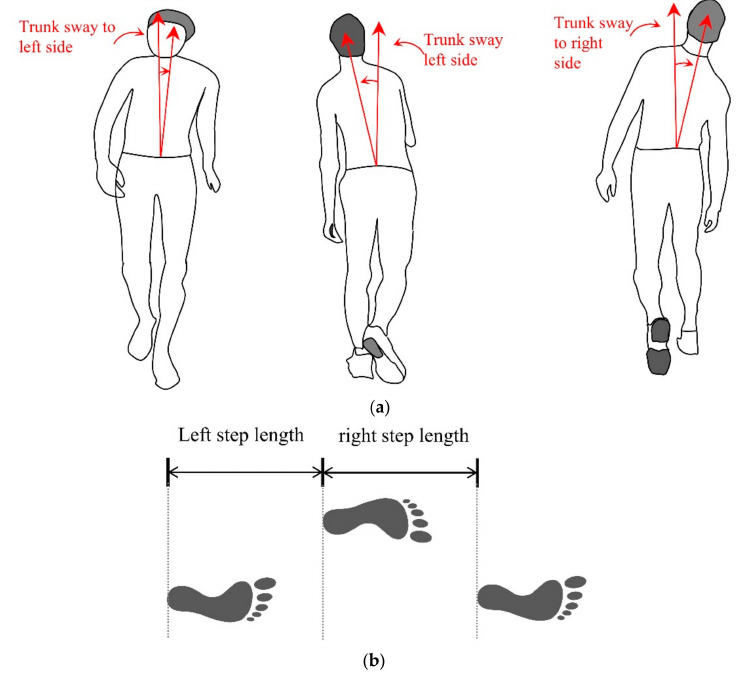
Figure 2. Illustration of trunk sway and step length. ( a ) Trunk sway; ( b ) Step